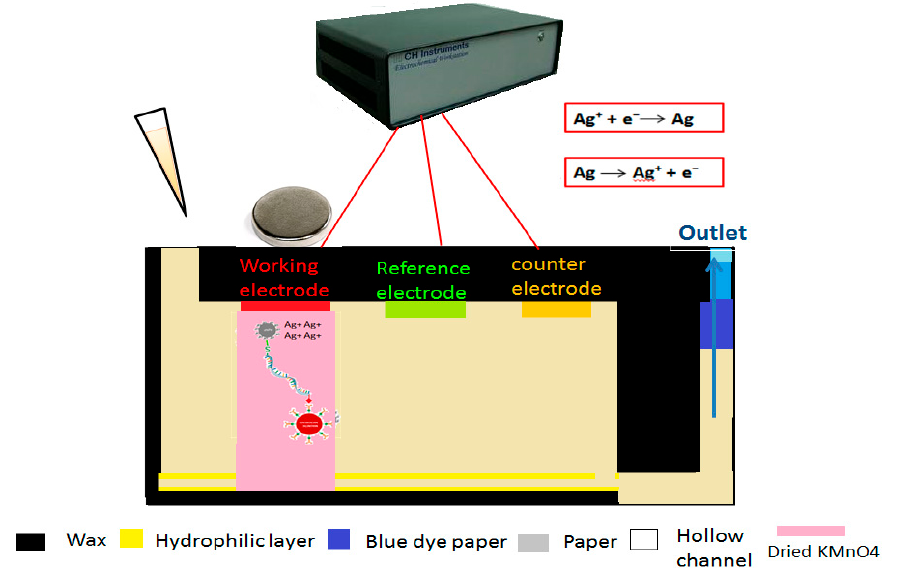
Figure 2. Working principle of paper analytical